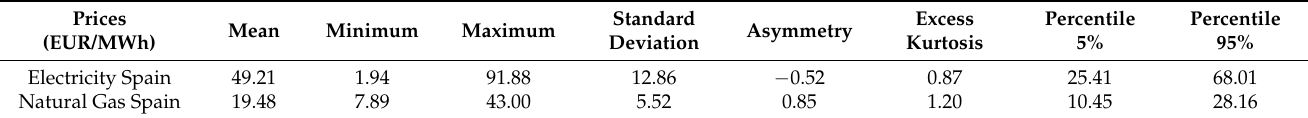
Table 1. Daily basic statistics